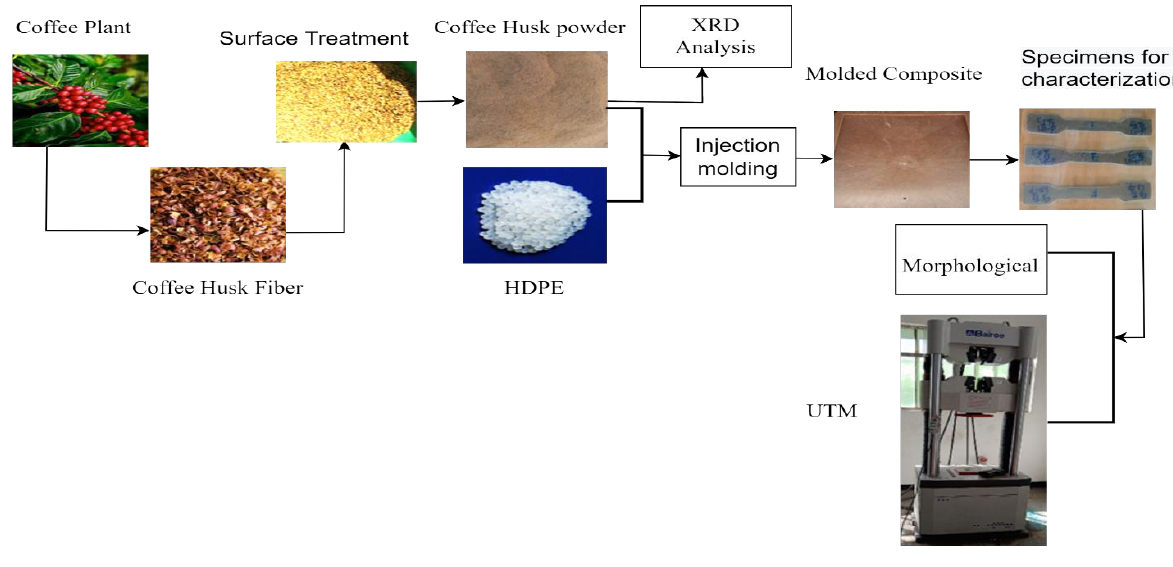
Figure 1. Representation of the processing sequence to produce UC and TC composites with their characterization.